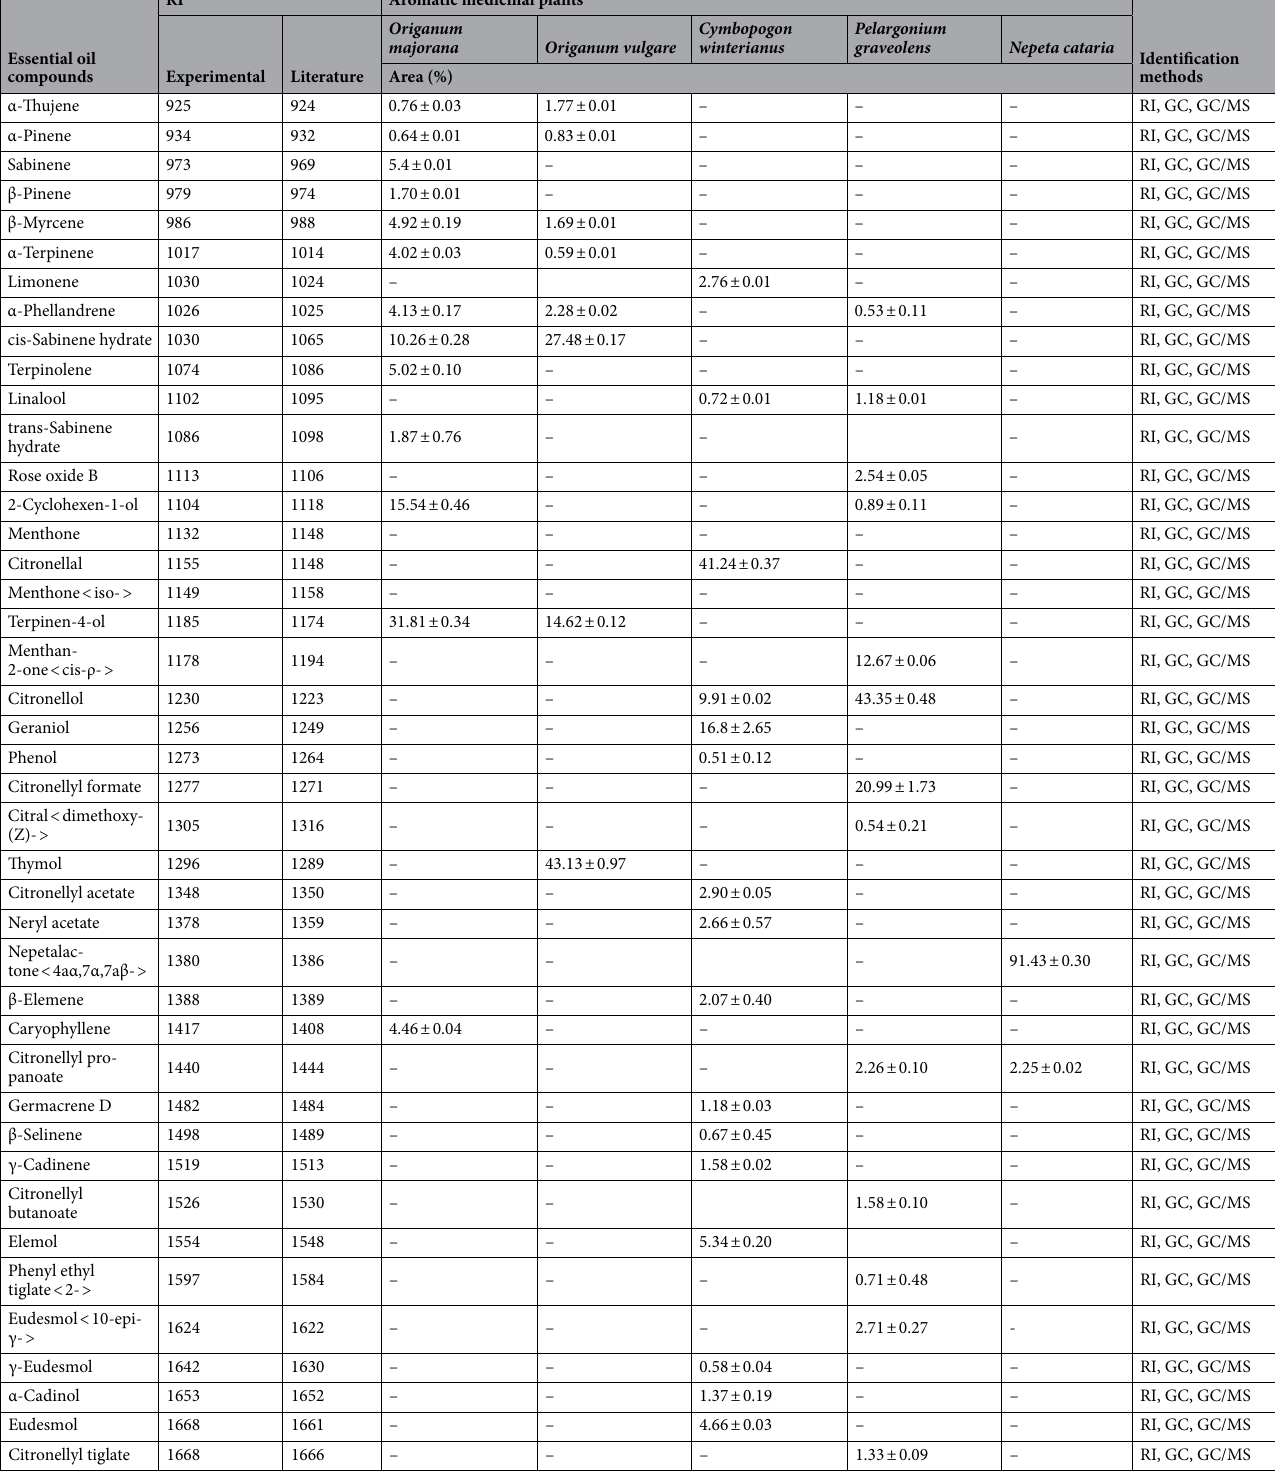
Table 1. The main volatile essential oil compounds in aromatic medicinal plants grown in the mid hill conditions of the western Himalaya. RI retention index, GC gas chromatography, GC/MS gas chromatography/ mass spectrometry. The values are mean ± standard